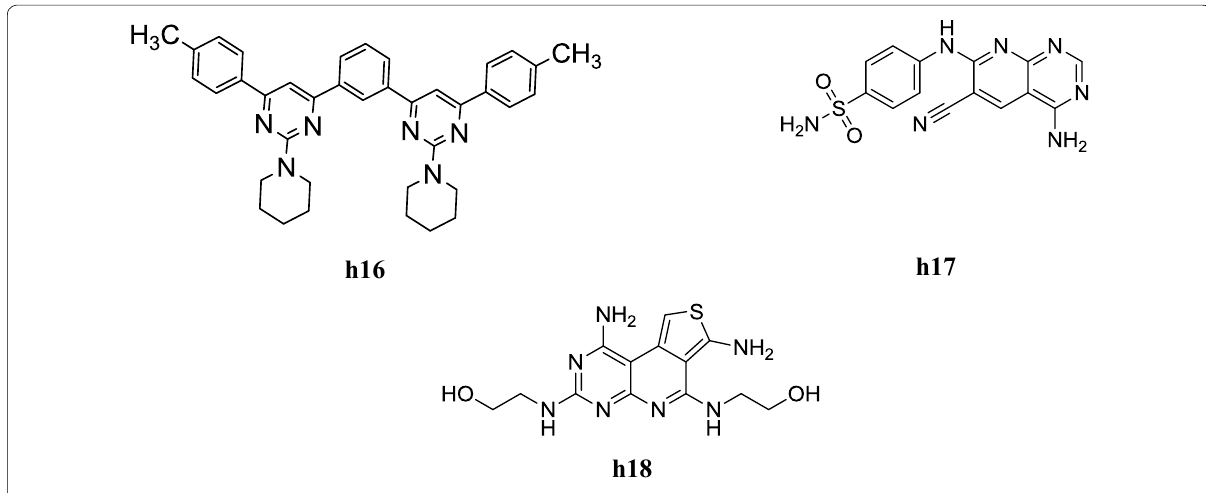
Fig. 15 Chemical structures of the most active pyrimidine derivatives ( h16 – h18